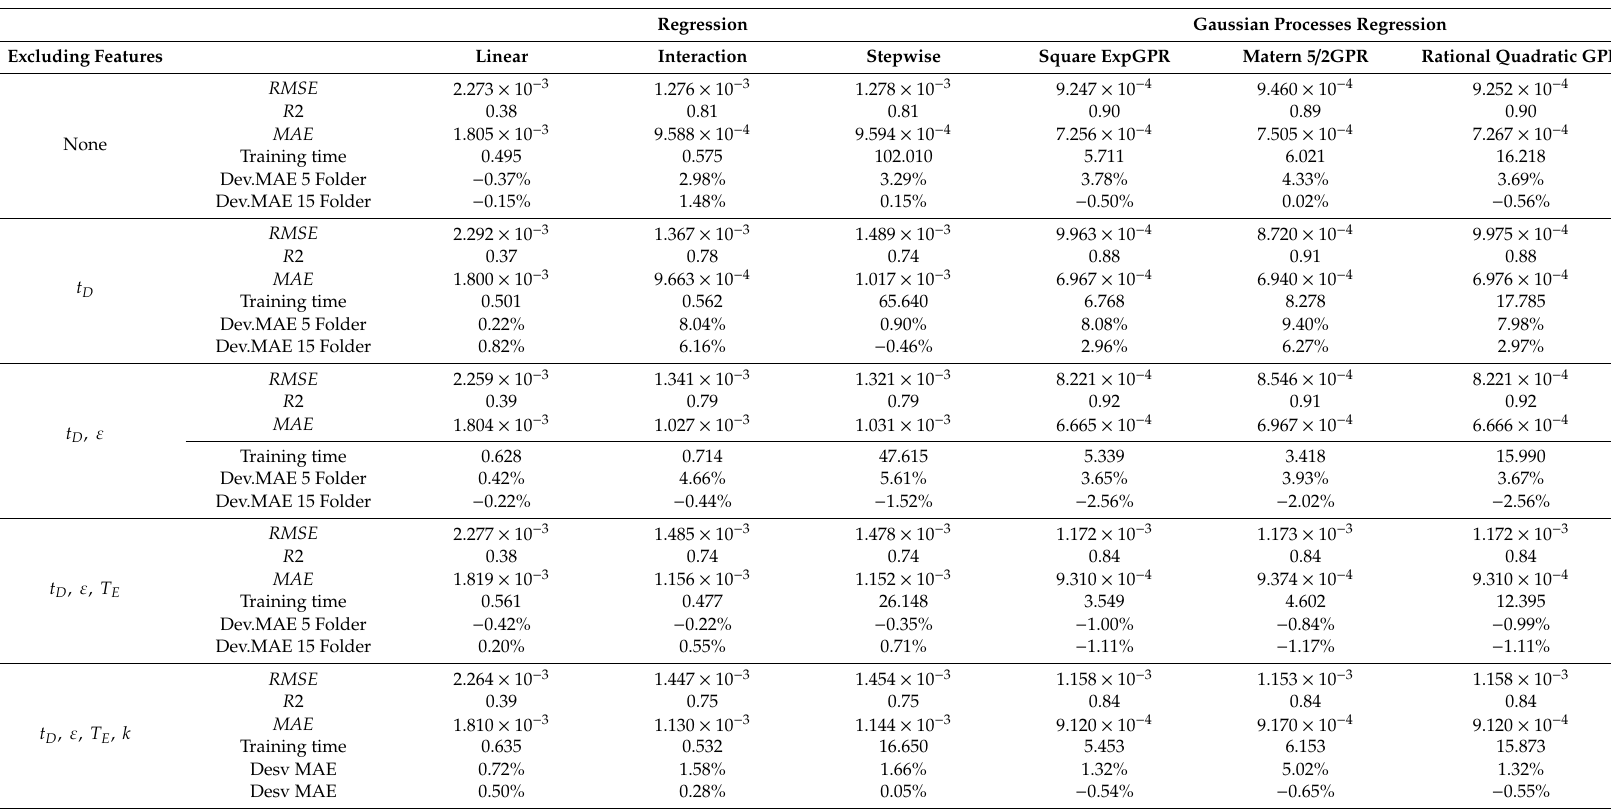
Table A3. Performance results for defect length predictor models using dataset of 500 sets of values. Regression and GPR when “Contrast Rear” is contemplated as